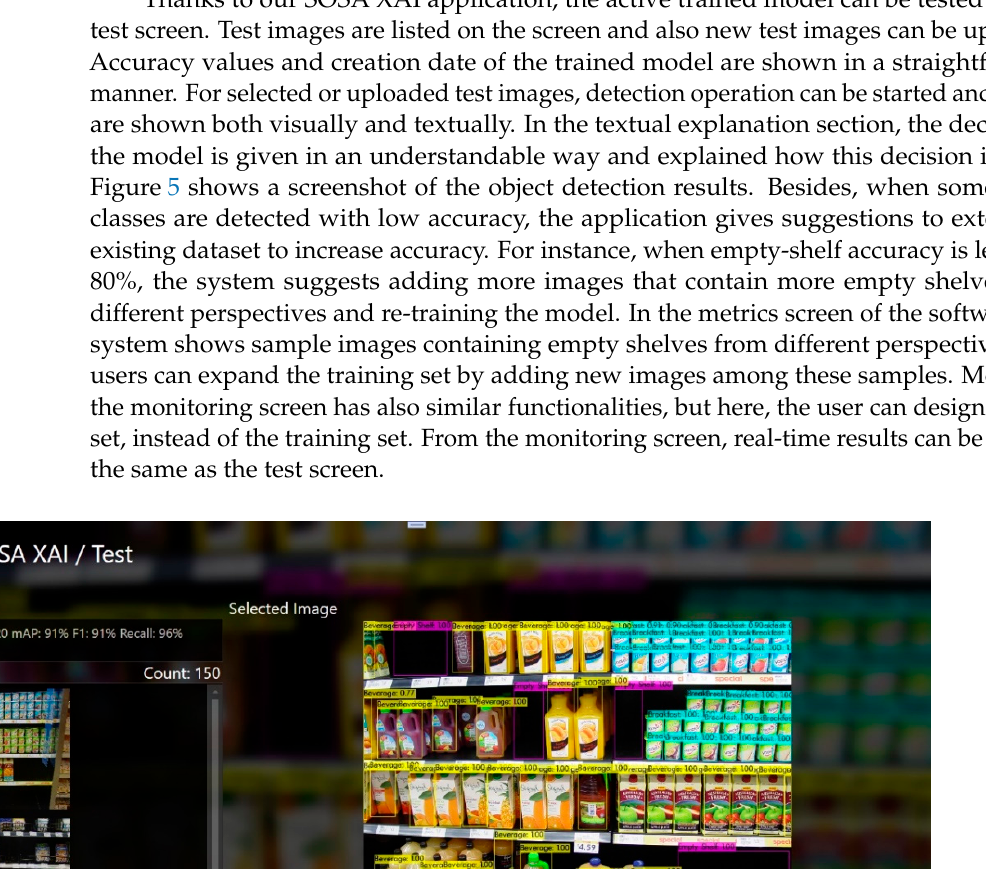
Figure 6. Metrics screen of SOSA XAI.